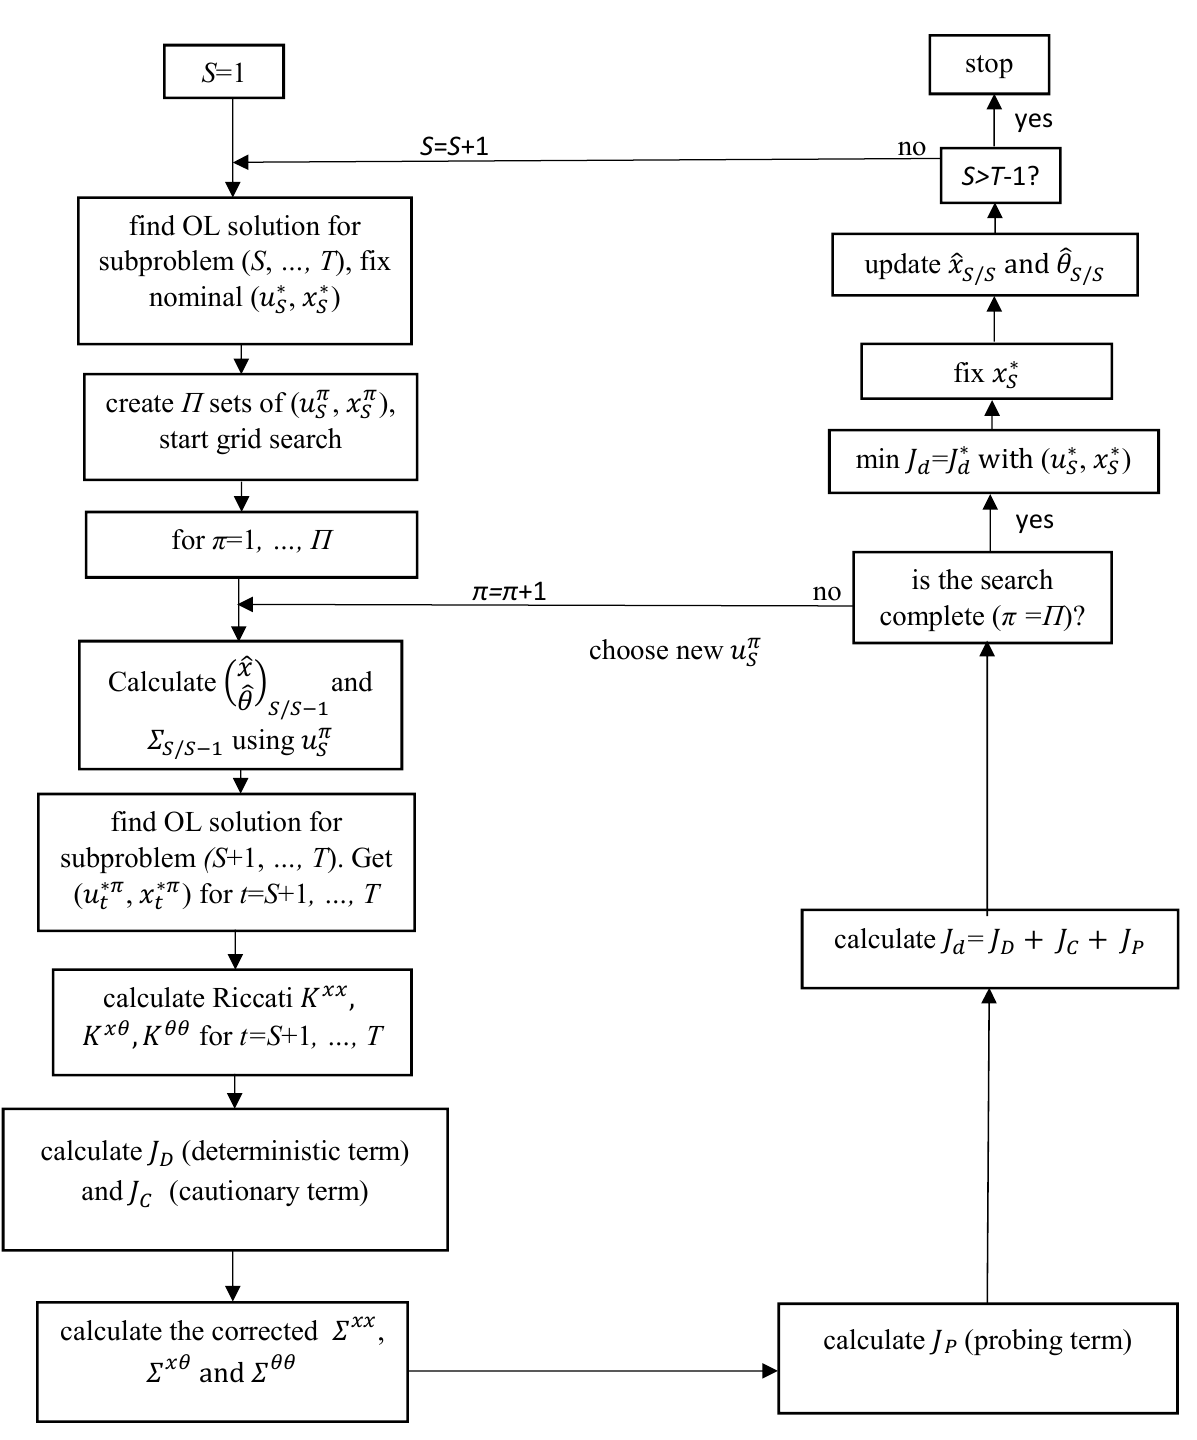
Figure 2. Flow chart of